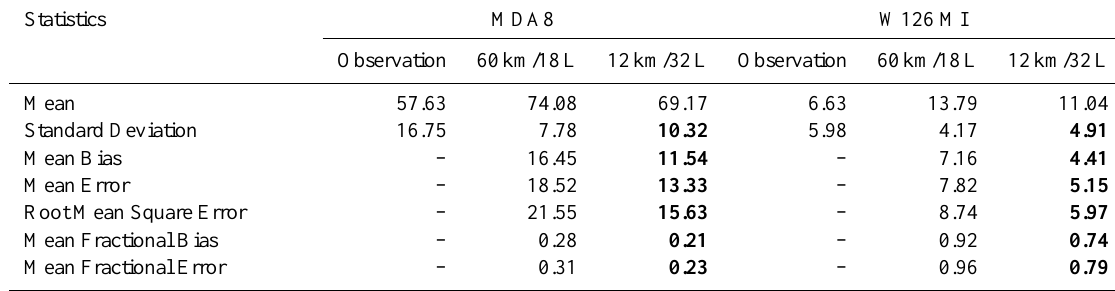
Fig. 5. The O 3 sensitivity to 50% reduction in O 3 boundary conditions. The surface O 3 sensitivity SEN1 (SEN1=base case-sensitivity case) of (a) W126; (b) MDA8 and (c) ratio of (a) / (b) . The surface O 3 relative sensitivity SEN2 (SEN2=(base case-sensitivity case)/base case) of (d) W126; (e) MDA8 and (f) ratio of (d) / (e) . Results are from the 60km/18 layer grid. The mean sensitivities in (a) and (b) are 5.4ppm-h and 15.5ppb, respectively, over the plotted domain. Table 4a. Statistics for observed and modeled surface O 3 metrics at EPA AQS sites as shown in Fig. 2 (better performance in bold). Model results were extracted at surface using the linear interpolation method a , b